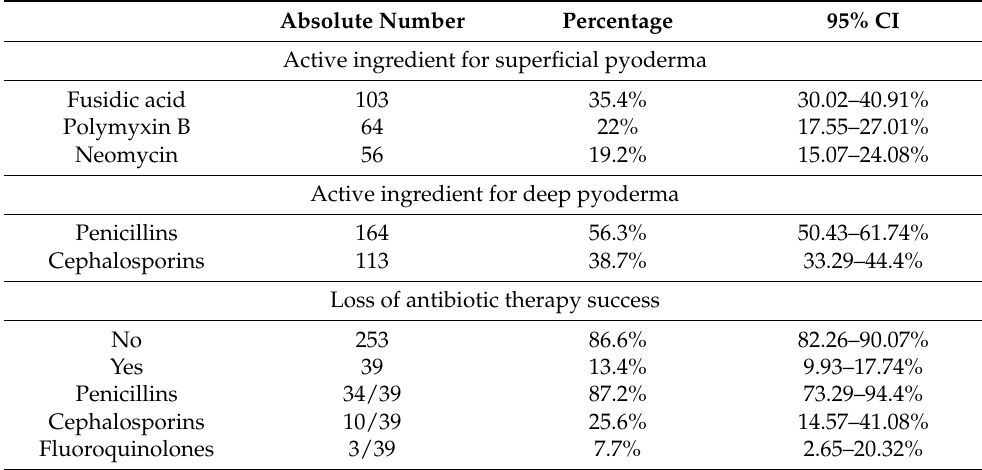
Table 5. Pyoderma. Number, percentages, and 95% CI of responses regarding the disease of pyoderma according to the frequency of the used active ingredients and the antibiotic groups for which a loss of therapeutic success was observed. A total of 292 questionnaires from a survey among German veterinarians were analyzed for this evaluation.